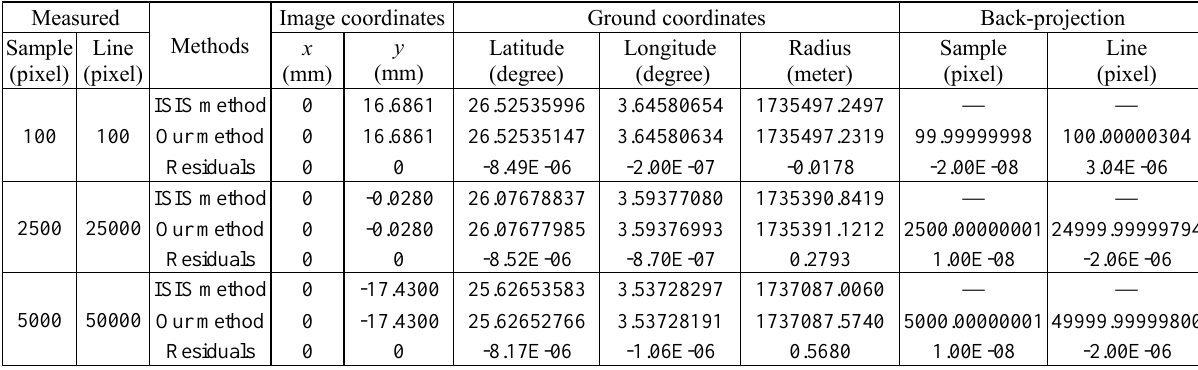
Table 3. Geometric accuracy evaluation of the generic rigorous sensor model using ISIS as reference.